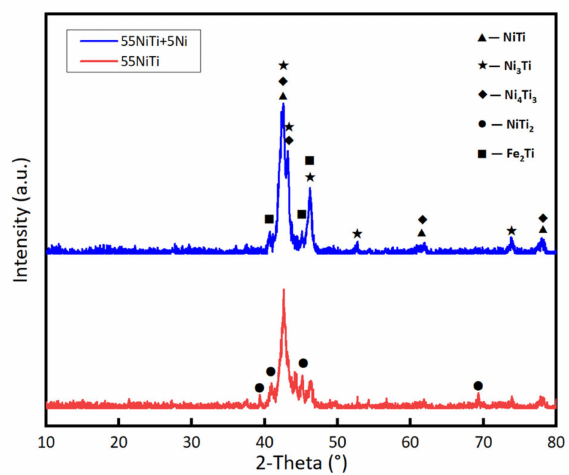
Figure 8. XRD patterns of 55 NiTi and 55 NiTi + 5 Ni laser cladding